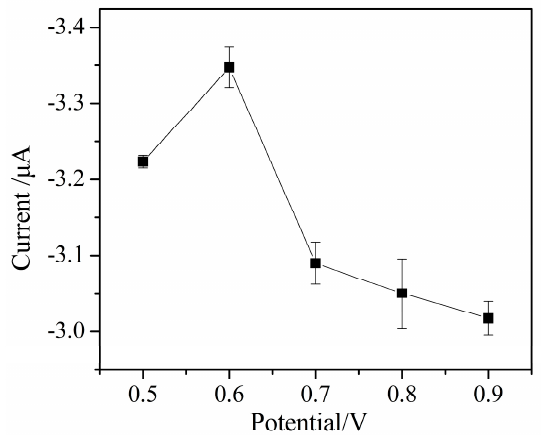
Figure 12. The e ff ect of preconcentration potential on the current response of Cr (VI) detection Figure 12. The effect of preconcentration potential on the current response of Cr (VI) detection (pulse (pulse size = 25 mV, frequency = 25 Hz, step size = 5 mV, 0.1 mol / L sodium acetate bu ff er, pH 6). size = 25 mV, frequency = 25 Hz, step size = 5 mV, 0.1 mol/L sodium acetate buffer, pH 6).